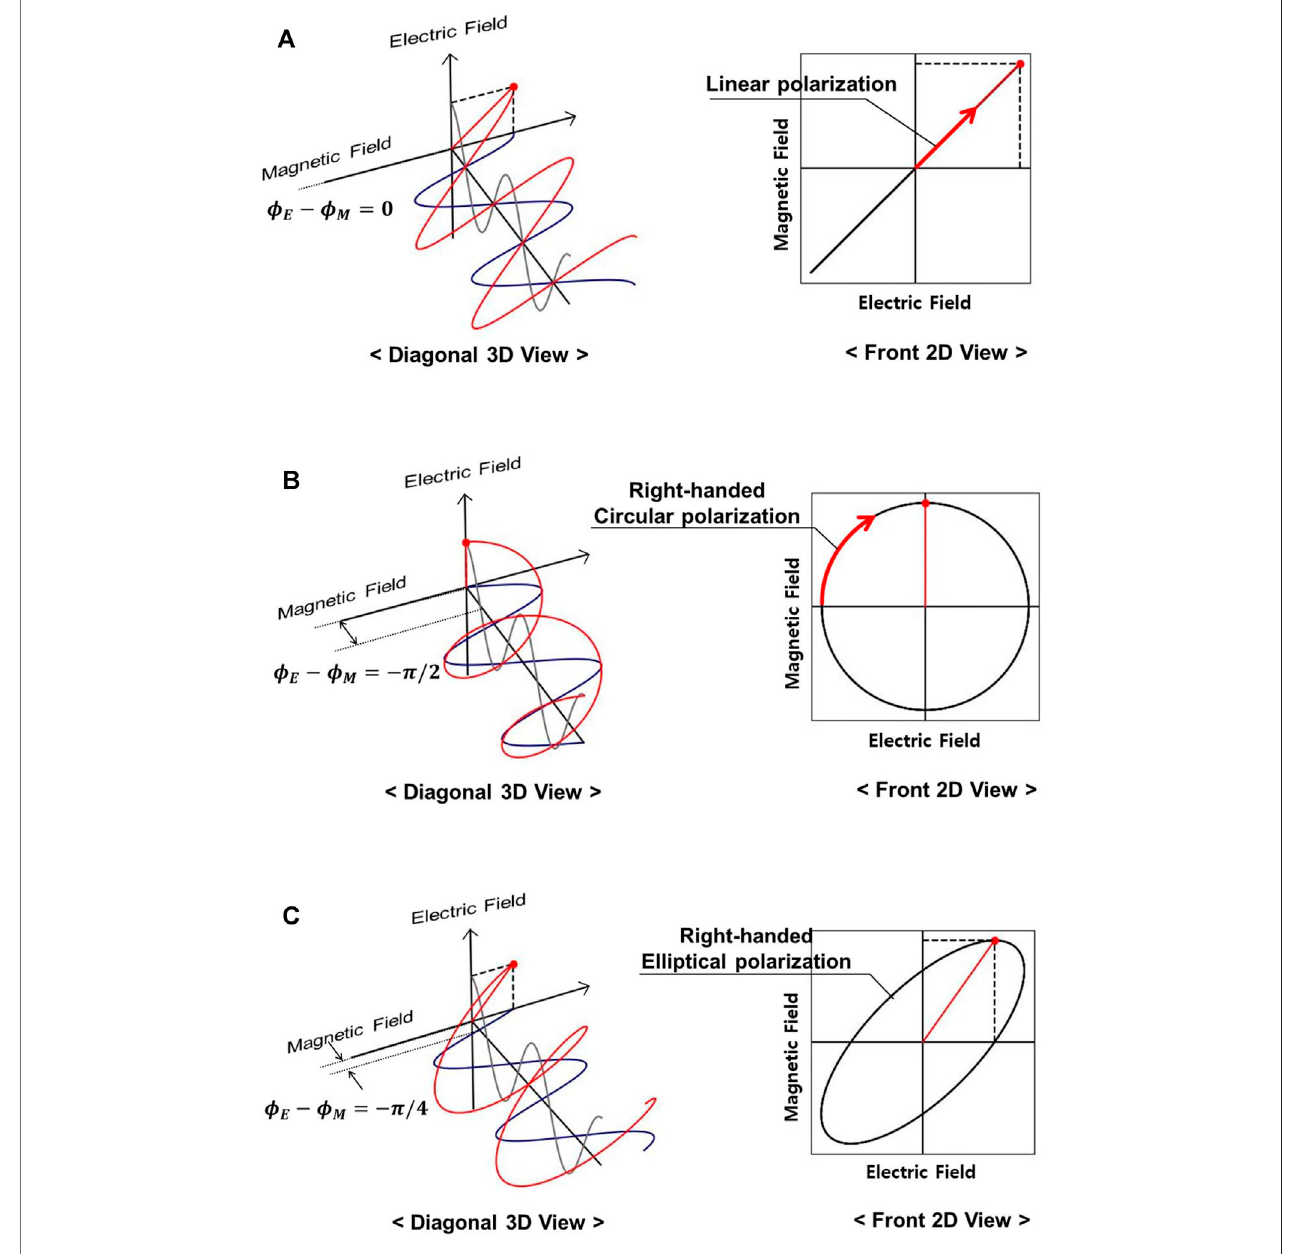
FIGURE 1 | Polarization that occurs depending on the phase difference. (A) Linear polarization (B) Circular polarization (C) Elliptical polarization.